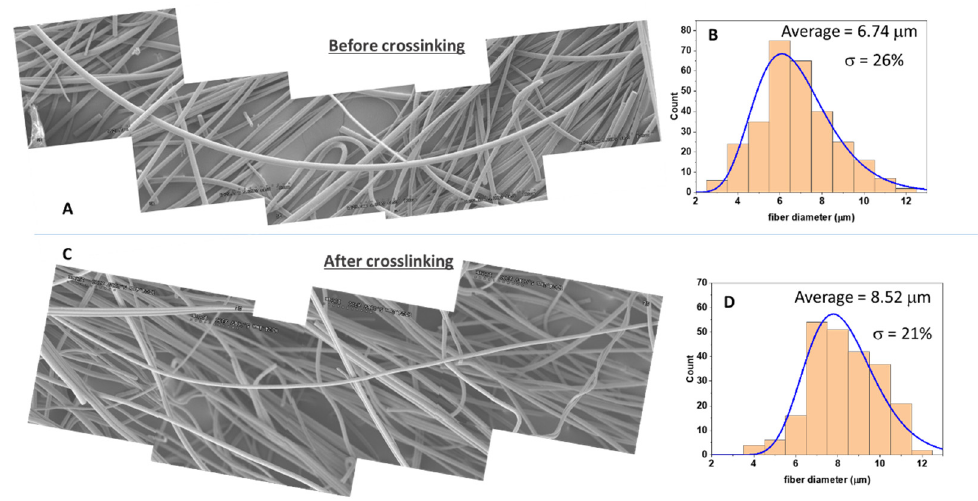
Figure 4. Assembled SEM pictures of fibers obtained by expt 1 (Table 1) before ( A ) and after ( C ) thermal treatment. The fiber that crosses all the images is approx 1 mm long. Each individual image has 490 × 220 µ m dimension. Histogram of the fiber diameters measured on 150 fibers, measured before ( B ) and after ( D ) thermal treatment.